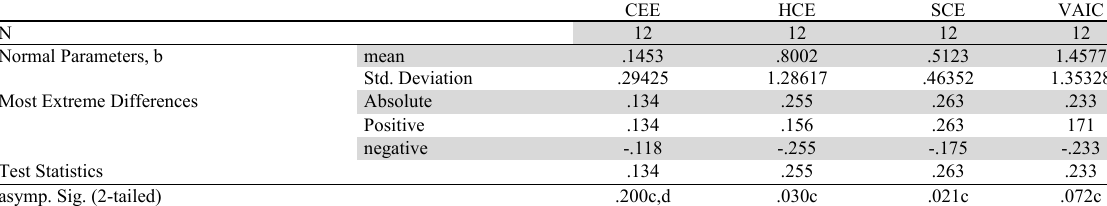
The results of One-Sample